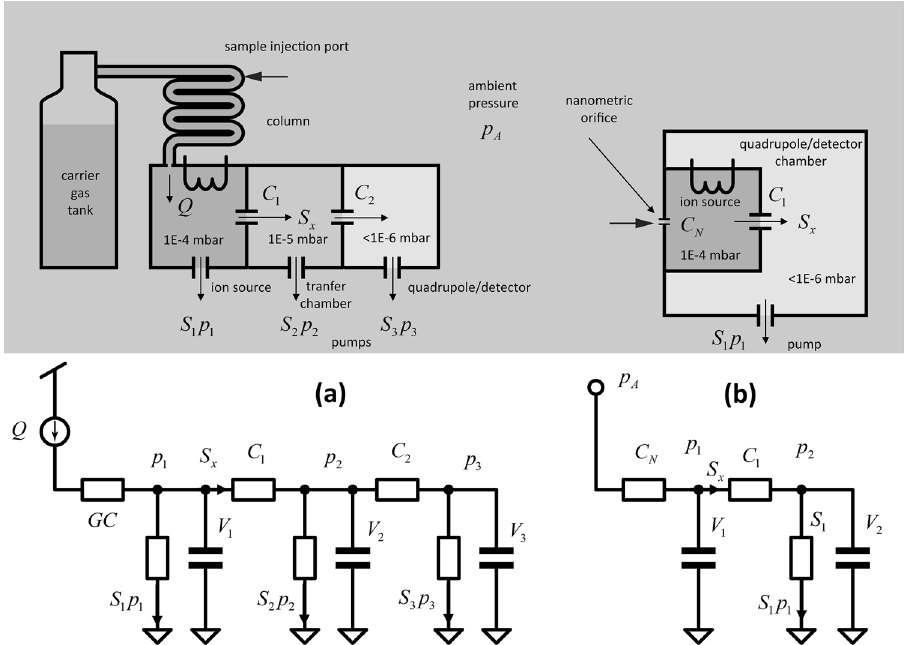
Figure 1. Comparison between conventional approach, ( a ) and nanodevice approach ( b ). The electric model lets us understand the pressure behavior between chambers at transient and steady-state regimes. The model